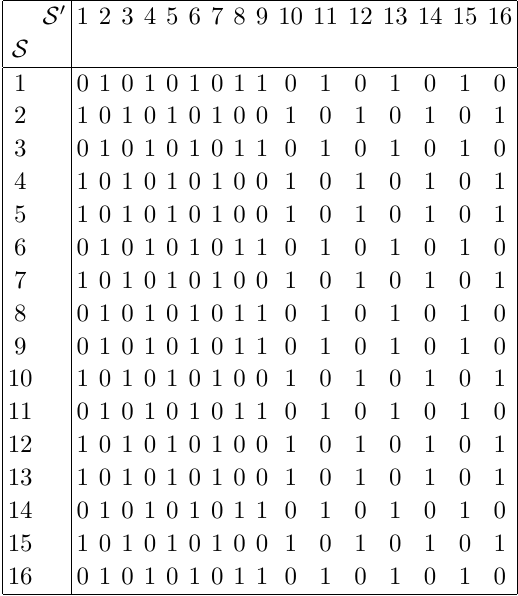
(cid:2) P with di(cid:11)erent boolean factors. [2] [5]